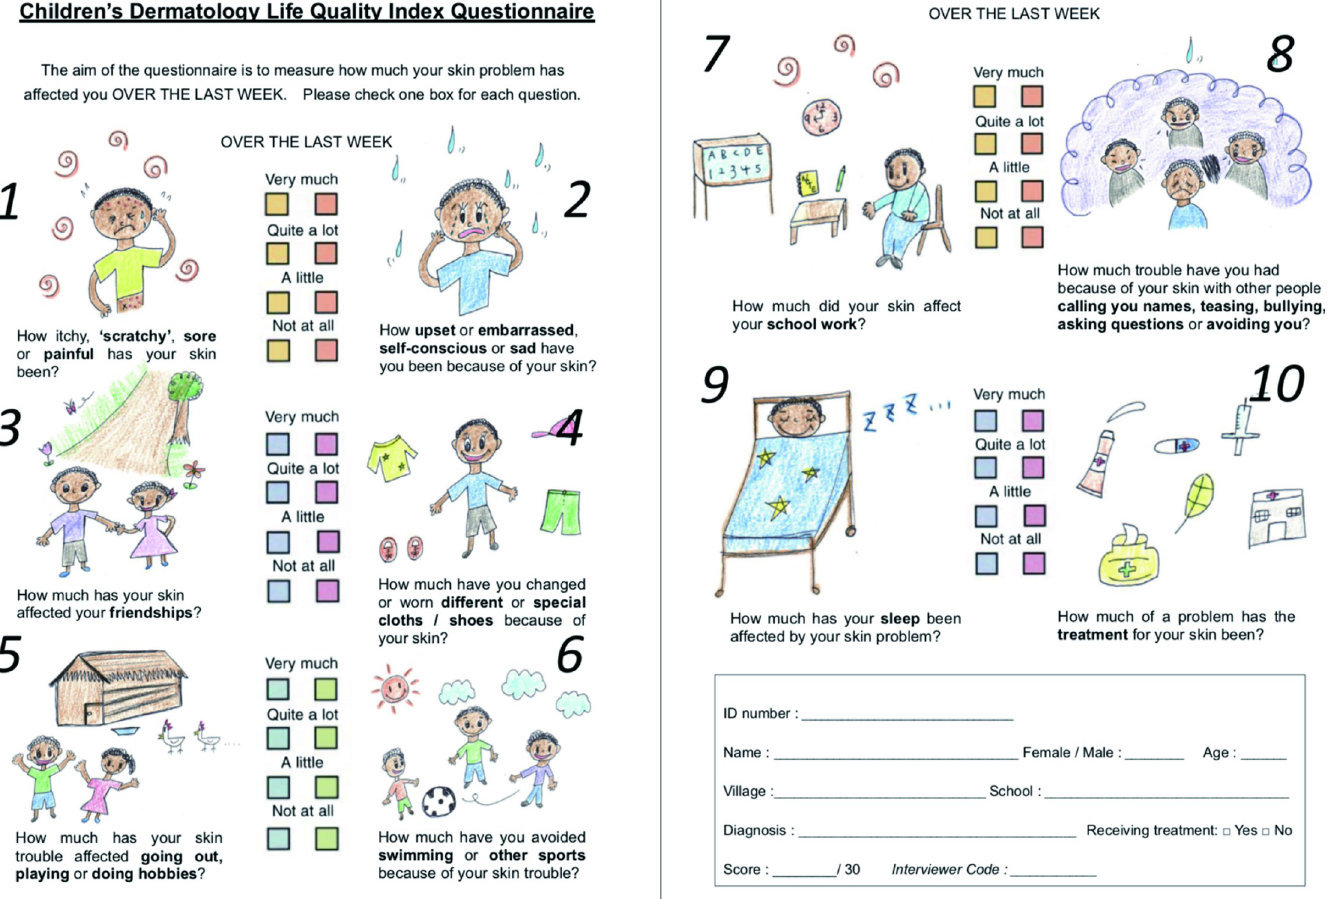
PLOS NeglectedTropical Diseases | https://doi.org/10.1371/journal.pntd.0008291 May 18,